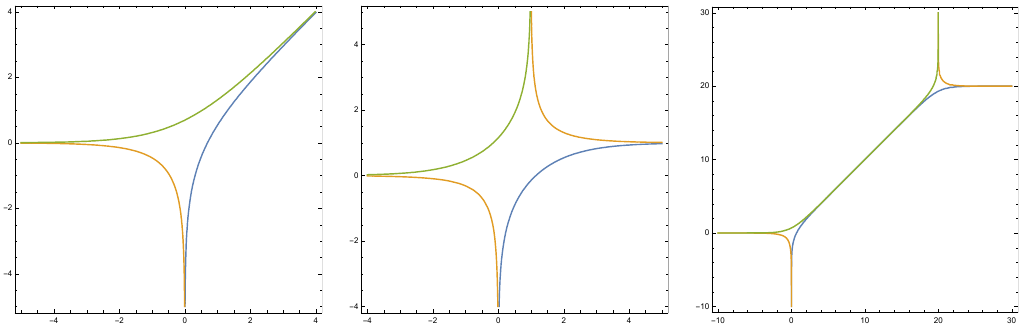
Figure 10 . Amoebas of the clover (left), conifold (middle), and resolved conifold (right) quivers. Then, we observe that the entropy density vanishes in the zero slope limit since lim (cid:27) ( n ; n ) = lim (cid:27) ( n ; n ) = 0 and this con(cid:12)rm its continuity across the n x ! 0 x y n y ! 0 x y